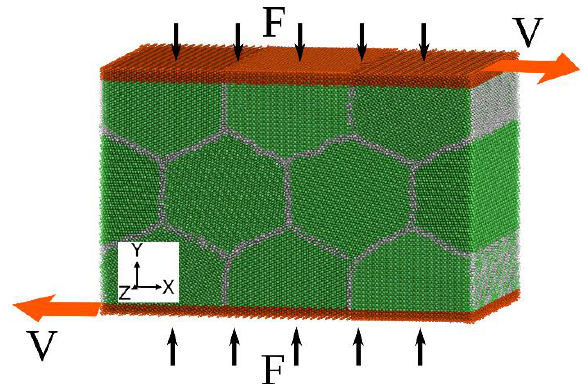
Fig. 1. The initial structure of the sample and the loading scheme. F is the pressing force, V is the shear velocity of grippers.